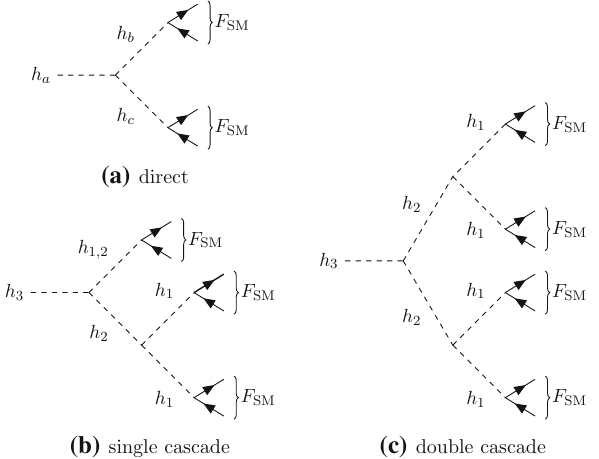
Fig. 5 Possible Higgs-to-Higgs decay signatures involving three neu- tral (mass ordered) scalars h a ( a ∈ { 1 , 2 , 3 } ): a h a → h b h c (with a > b , c ) with successive decay of h b and h c to SM particles; b h 3 → h 2 h c (with c ∈ { 1 , 2 } ) with successive decay h 2 → h 1 h 1 and h k as well as all h 1 decaying to SM particles; c h 3 → h 2 h 2 → h 1 h 1 h 1 h 1 and all